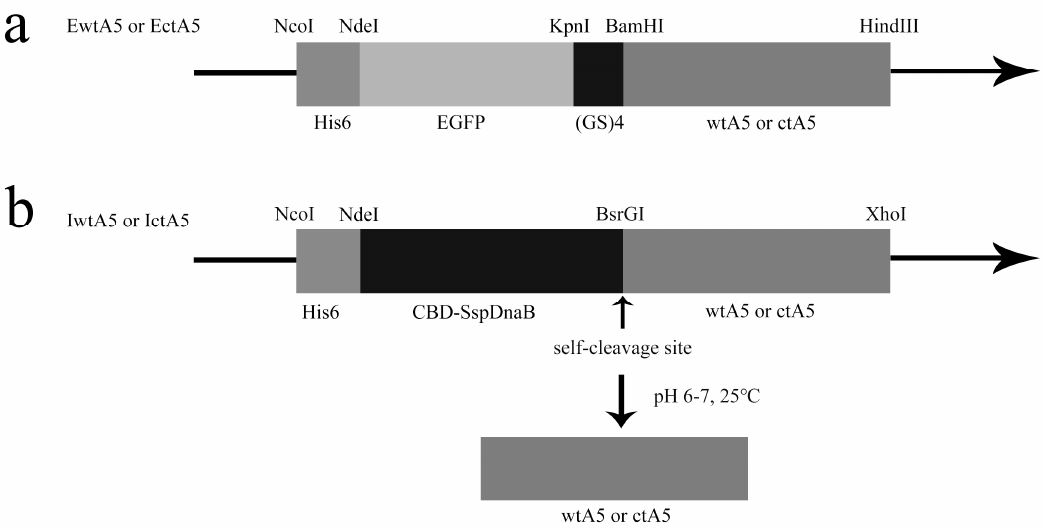
Figure 2. AnxA5 expression vectors. ( a ) EwtA5 and EctA5 protein expression vectors. The wtA5 or ctA5 coding sequence was fused to the C-terminal of EGFP via a (GS) 4 linker, and the expressed proteins were able to be purified by Ni-affinity chromatography utilizing the His-tag. ( b ) IwtA5 and IctA5 protein expression vectors. The wtA5 or ctA5 coding sequence was fused to the C-terminal of CBD-SspDnaB. The expressed proteins were able to adsorb to the Ni-affinity resin, and the non-fusion protein wtA5 or ctA5 was obtained using the self-cleavage property of SspDnaB intein at its last residue. The restriction enzymes used, and the proteins or amino acid chains coded, are shown above and below the vectors, respectively. His 6 , His-tag for Ni-affinity chromatography; EGFP, enhanced green fluorescent protein; (GS) 4 , fusion protein linker; CBD-SspDnaB, intein.